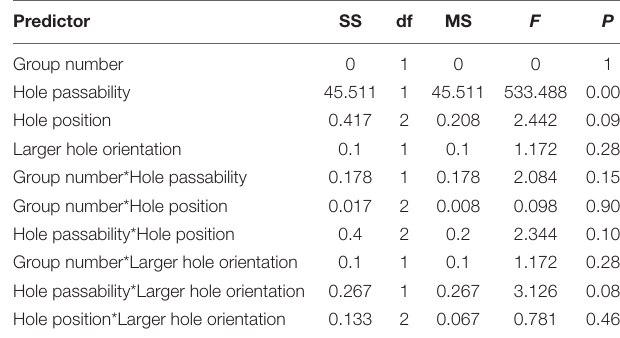
TABLE 3 | Results of the Experiment 2 of 12 test trials: assessment of the influence of various predictors (group number, passability of the hole, position, orientation of the larger hole) on the number of first attempts to pass in a trial, the factorial ANOVA.